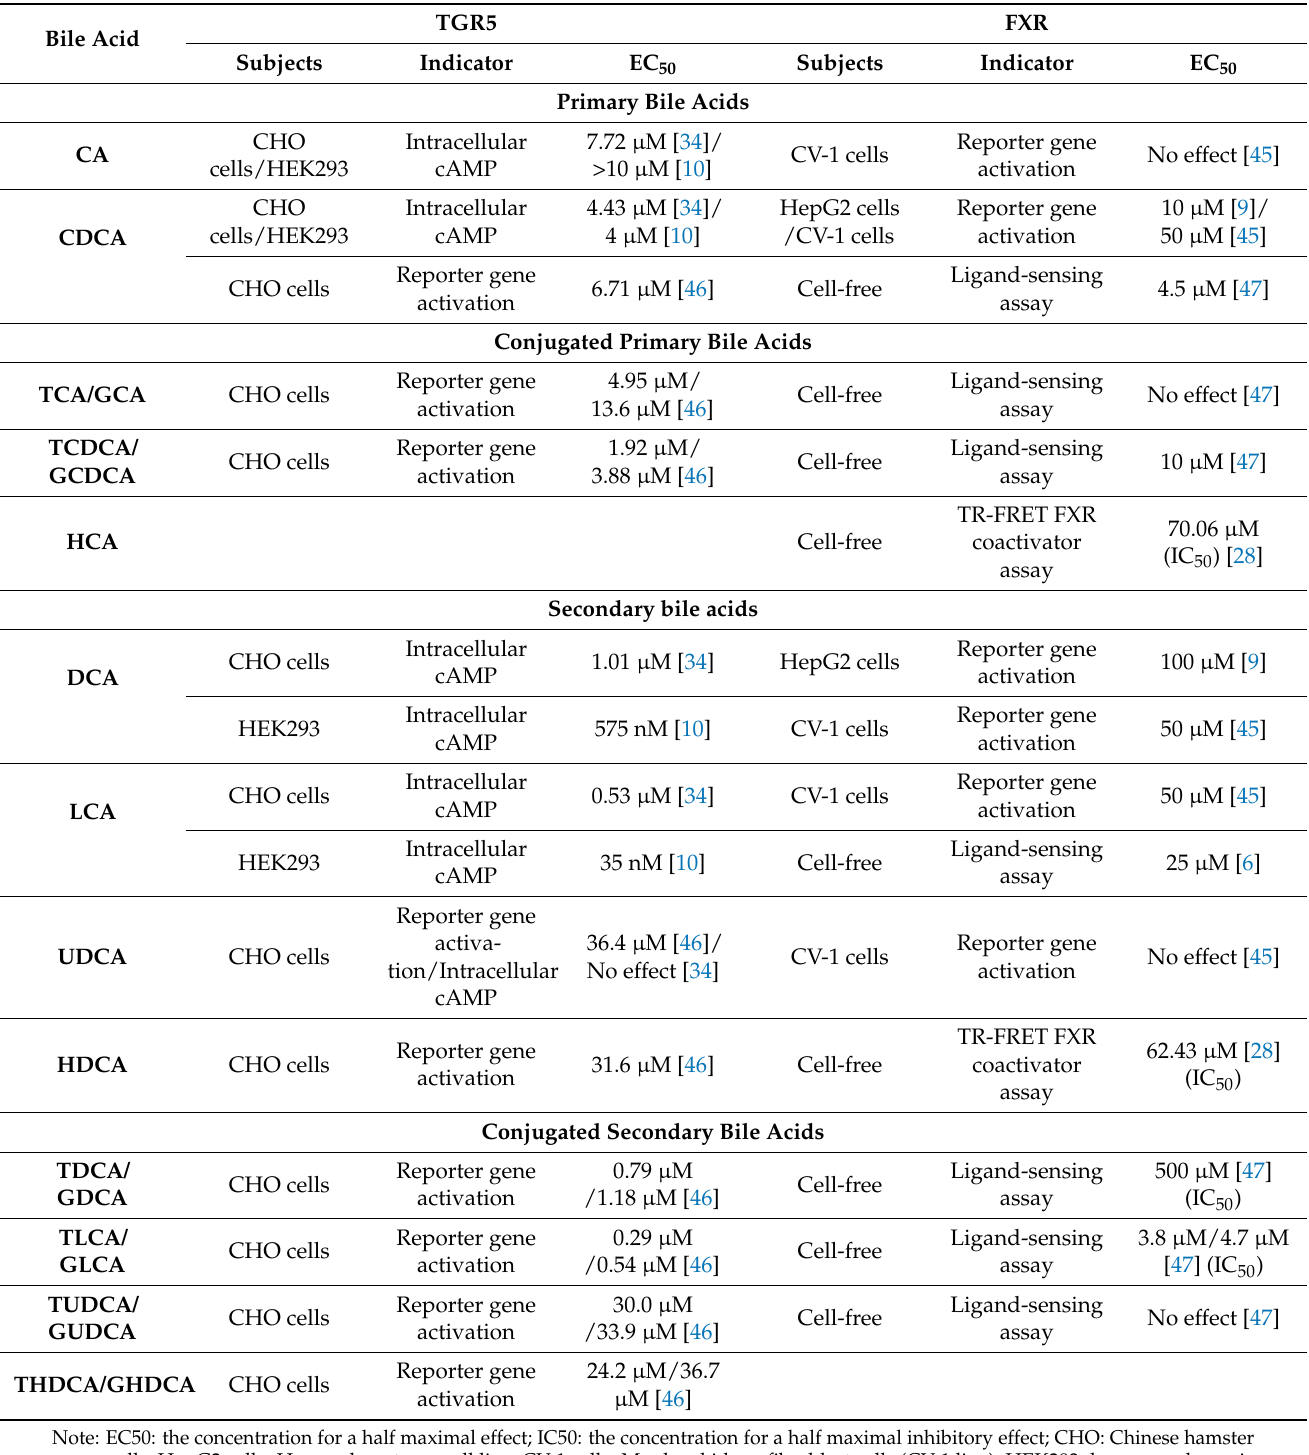
Table 1. Binding affinities of bile acids to human TGR5 and